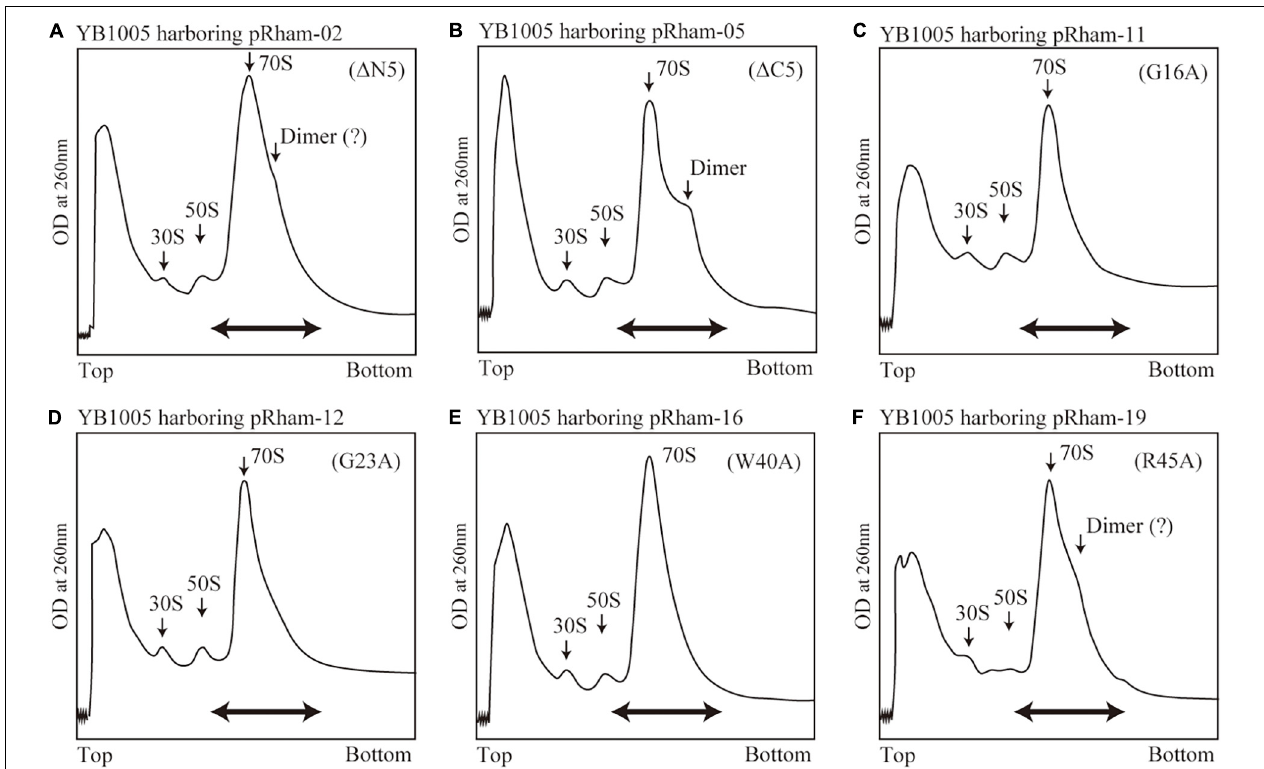
FIGURE 3 | Impact of rmf mutations on the formation of 100S ribosomes. The mutant strains shown in Table 1 were cultivated in EP-medium containing 0.8% rhamnose and harvested 24 h after inoculation. The ribosome profiles were analyzed by SDGC method. (A,B) Represent the strains expressing RMF truncated by 5 amino acids at N- and C-terminus, respectively; (C–F) Represent strains expressing RMF in which the conserved amino acids, glycine (G), cysteine (C), and tryptophan (W), respectively, were substituted with alanine (A) (see Figure 1 and Supplementary Figure 1 ). The double-headed arrows indicate the fractionated regions that were analyzed by western blot (see Figure 5